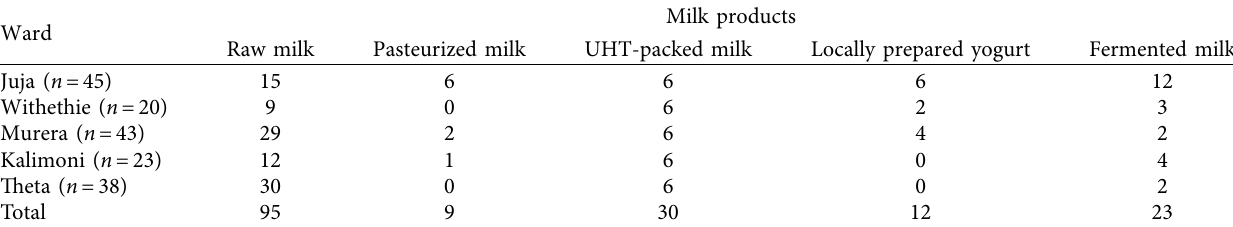
Table 1: Milk products sampled in Juja Sub-County, Kenya ( n �